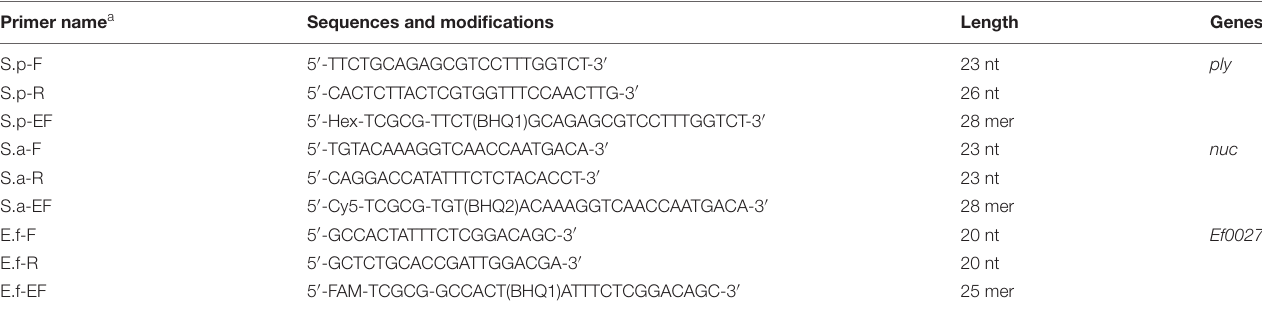
TABLE 1 | Primers used in this